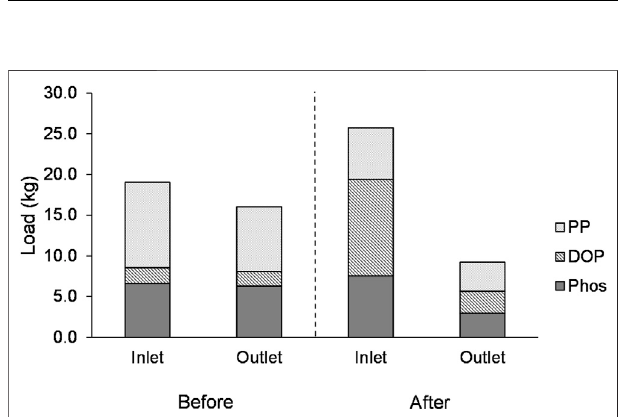
FIGURE 5 | Event fl ow sum nitrogen loads at the CW inlet and outlet, before and after maintenance.